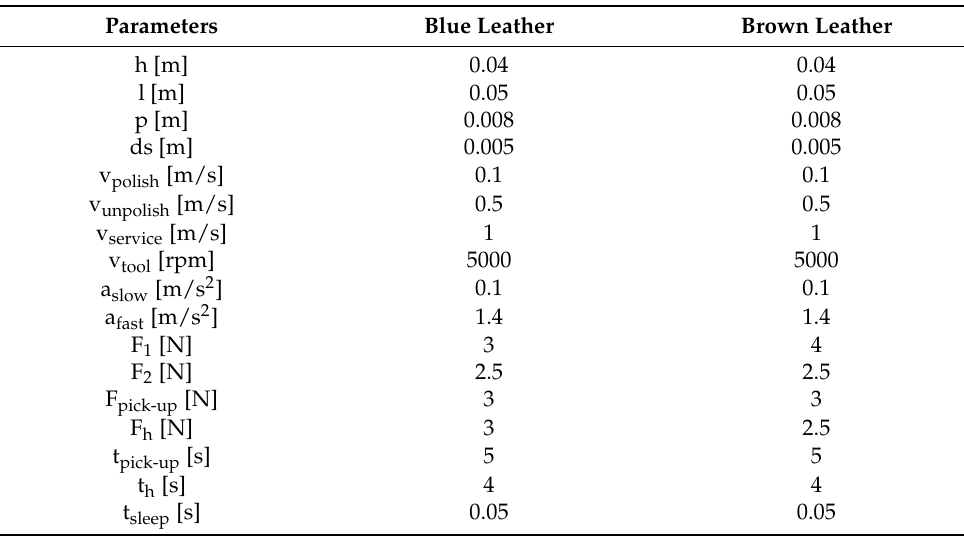
Table 2. Inputs of the process related to the results shown in Figure